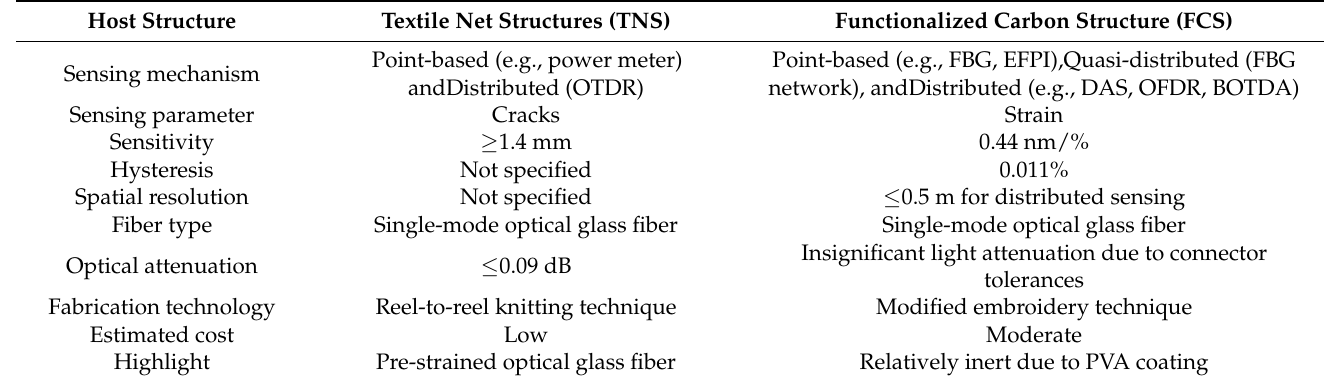
Table 1. Comparison of functionalized TNS and FCS. Values obtained from [51,68,95,96]. Host